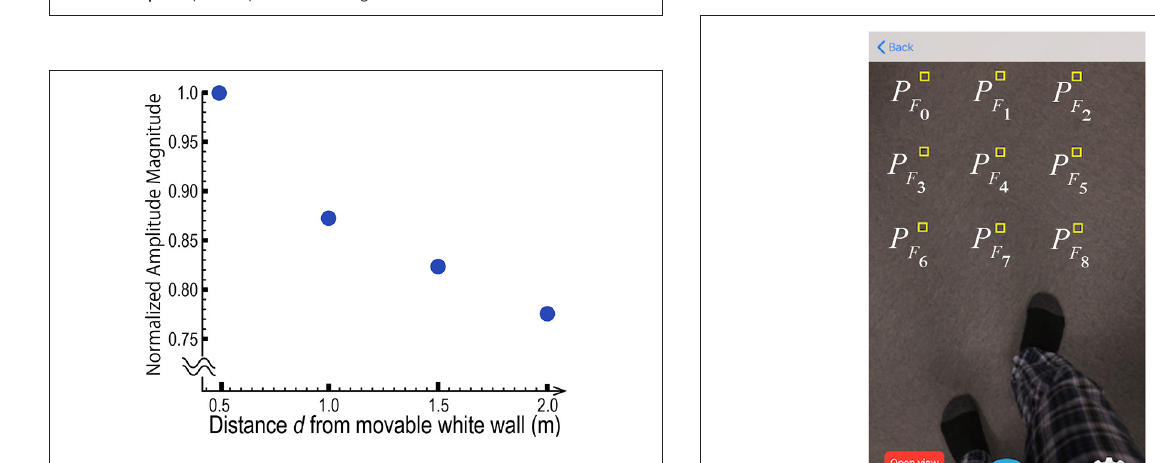
FIGURE 9 | Multipath experiment setting.